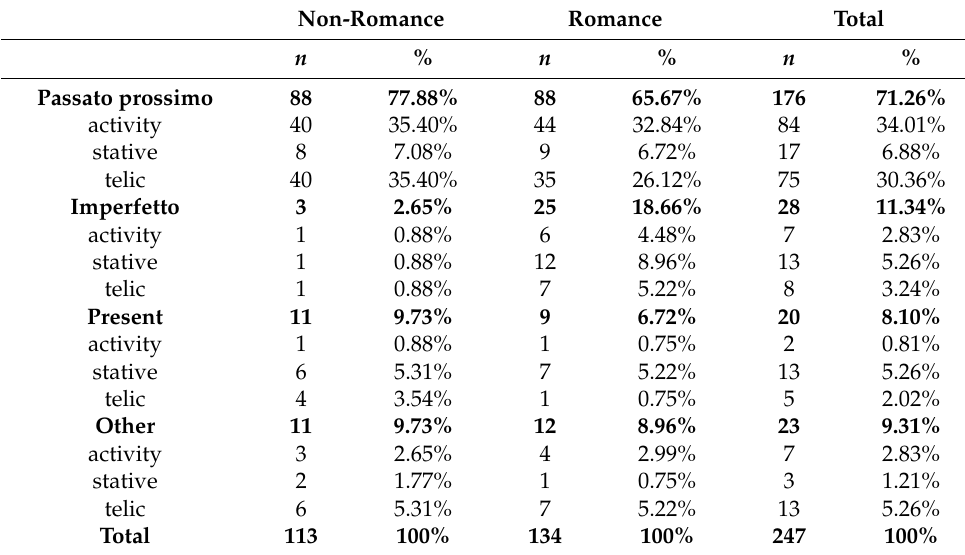
Table 4. Number of occurrences ( n ) and percentage (%) of tenses employed by low-proficiency learners in perfective